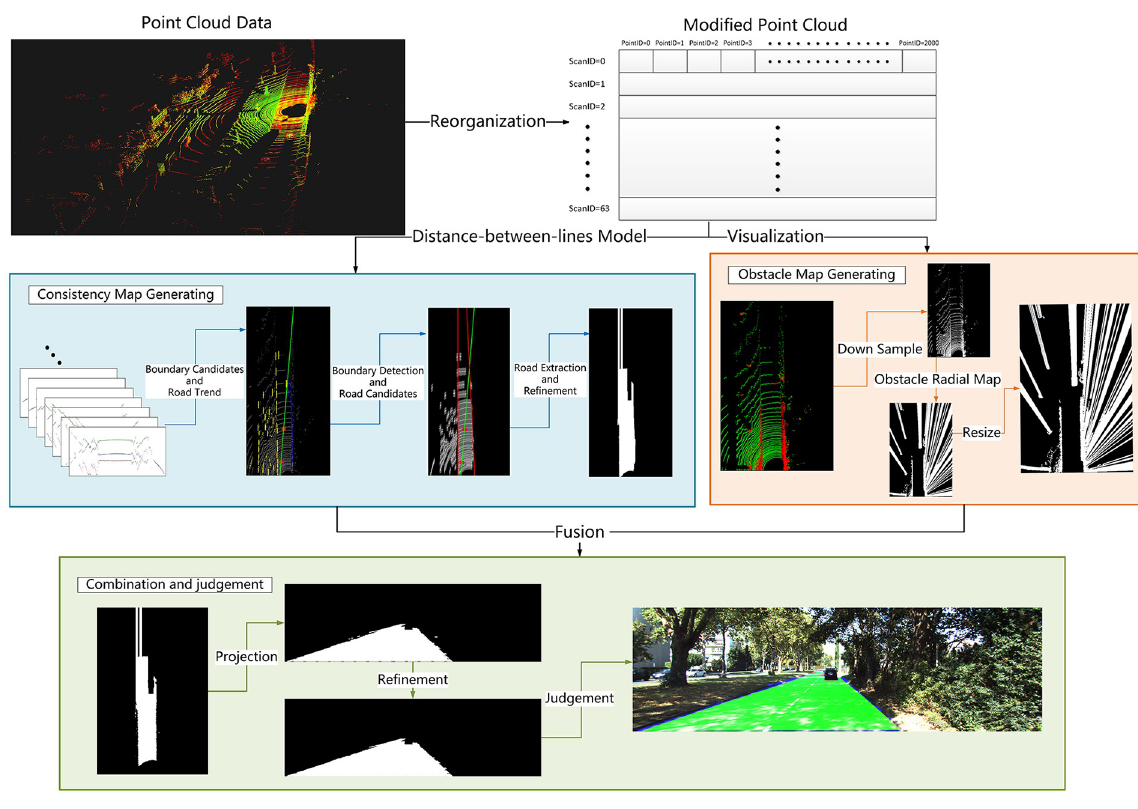
Fig 6. Processing